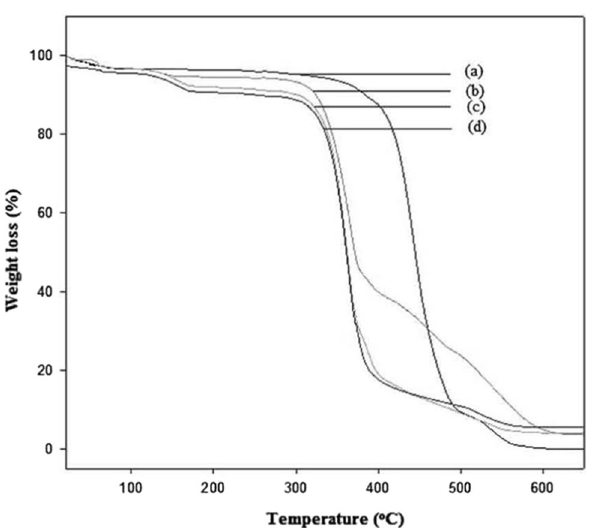
Fig. 3 TG thermograms of a nylon 6/6, b 10 wt% ZnO/nylon 6/6, c 20 wt% ZnO/nylon 6/6 and d 30 wt% ZnO/nylon 6/6